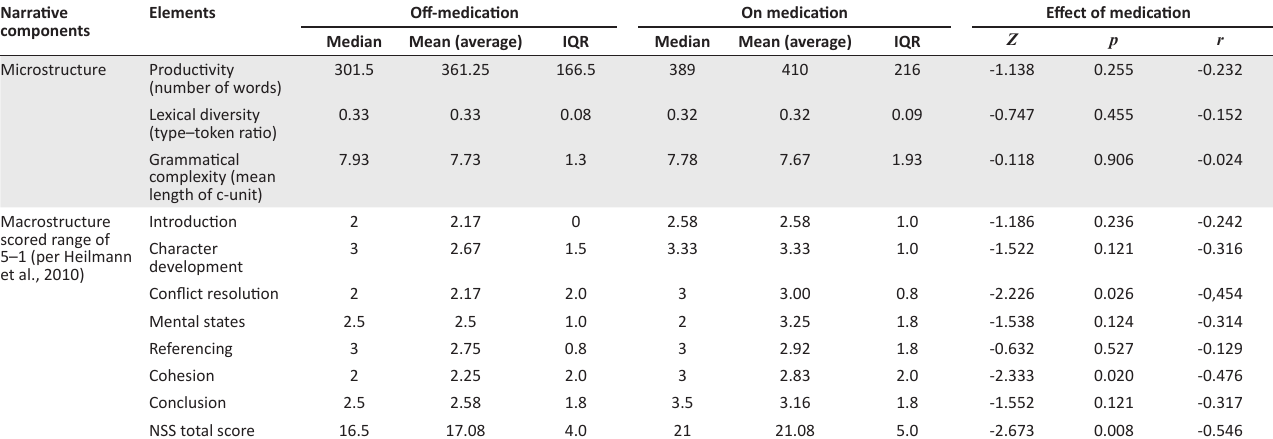
TABLE 3: Effects of MPH-OROS® on the narrative production of children with attention-deficit hyperactivity disorder. Narrative components